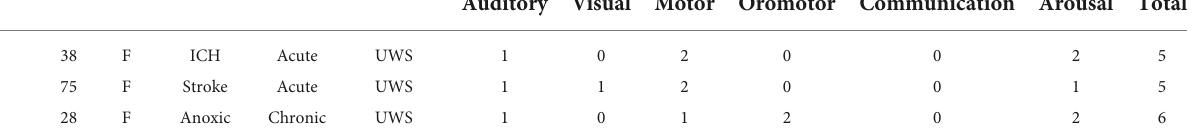
TABLE 1 Demographic and clinical data of patients.